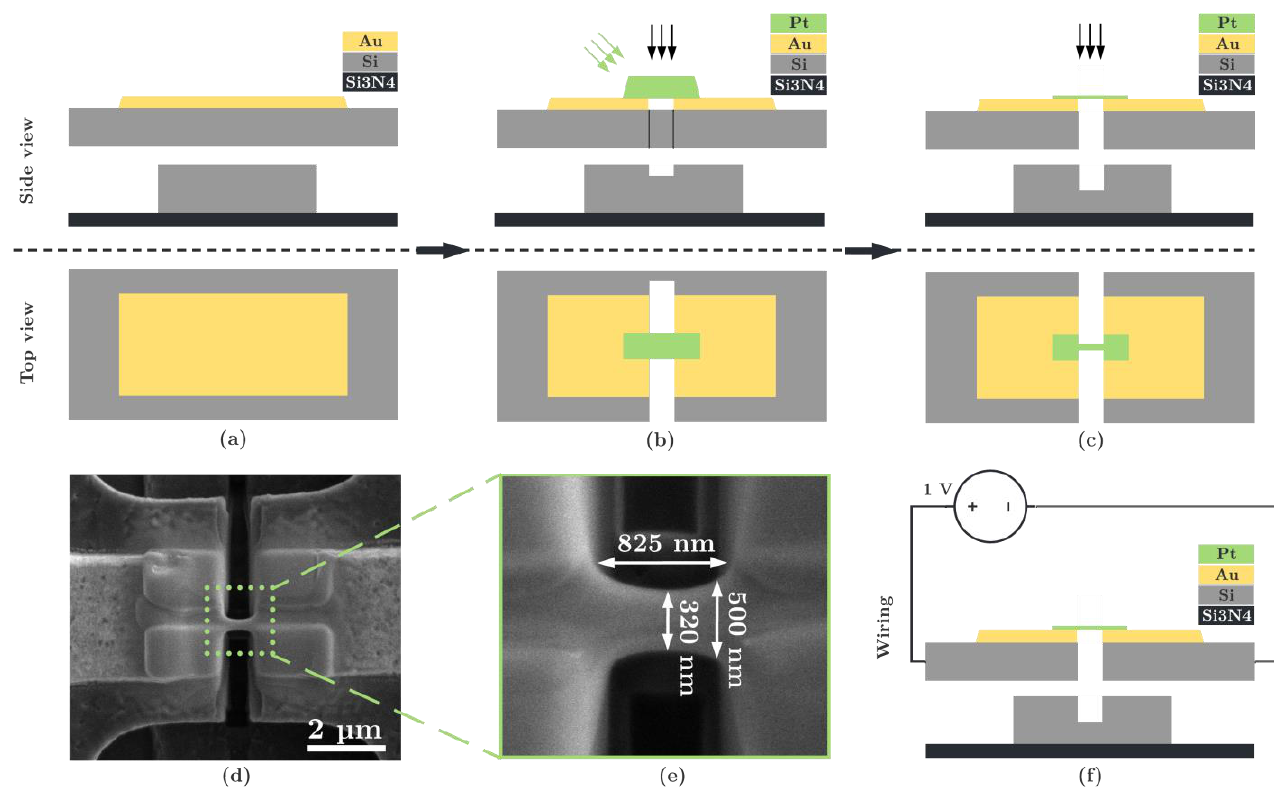
Figure 4. Sample preparation for measuring the material resistance of the PtC nanobeams. Top: principle of fabrication: ( a ) initial state of a free-standing PolySi structure (thickness = 1.5 µ m) with a gold pad, ( b ) FIB cut of the PolySi structure and subsequent deposition of a PtC bump, ( c ) patterning of the PtC bump and subsequent final separation of the PolySi structure. The underlying PolySi pad (thickness = 2 µ m) serves as protection against unwanted vias to the silicon nitride (Si 3 N 4 ) layer and the chip substrate. Bottom: ( d ) SEM image of the final PtC nanowire and ( e ) detailed image with exemplary geometric dimensions. ( f ) Principle of wiring.